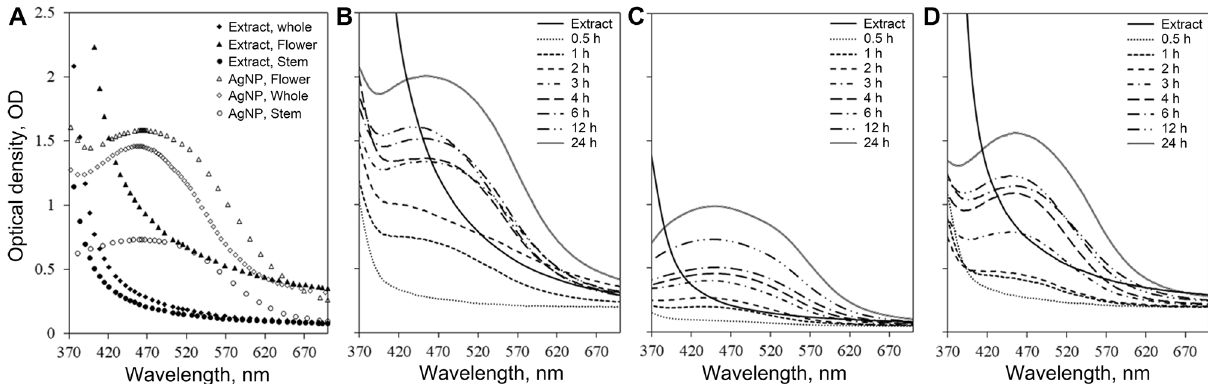
Figure 2. UV–Vis spectra for the reaction mixture containing of silver nanoparticles synthesized from Carduus crispus flower (AgNP-F), stem (AgNP-S) and whole plant (AgNP-W). Shown are the UV–Vis absorption spectra from 370 to 700 nm of all plant organs and synthesized ( A ) AgNPs, ( B ) AgNP-W, ( C ) AgNP-S, and ( D ) AgNP-F.